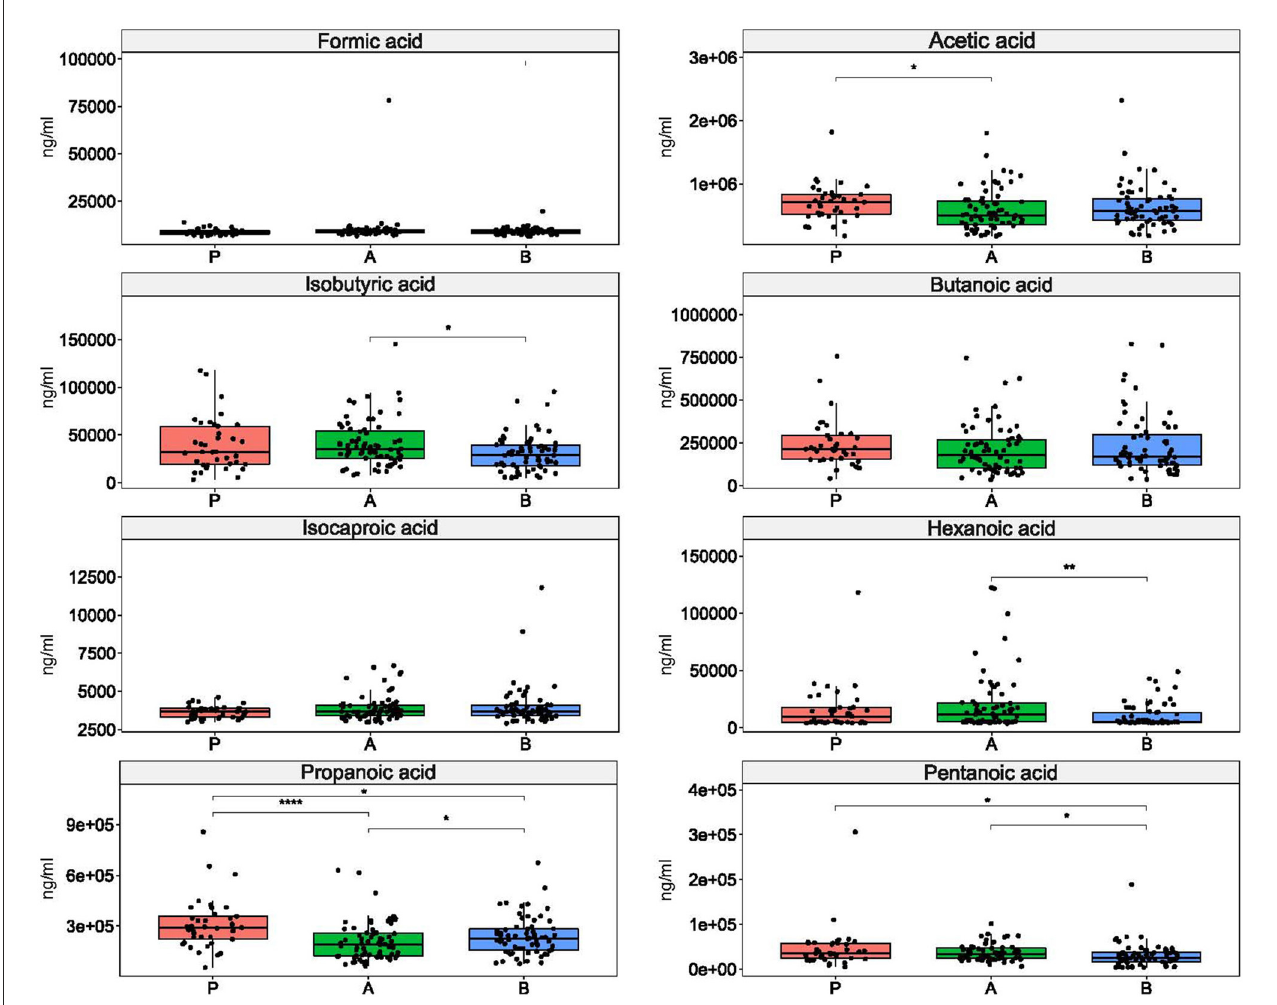
FIGURE5 Differences in short chain fatty acid concentrations between enterotypes. *: p ≤ 0.05, **: p ≤ 0.01, ****: p ≤